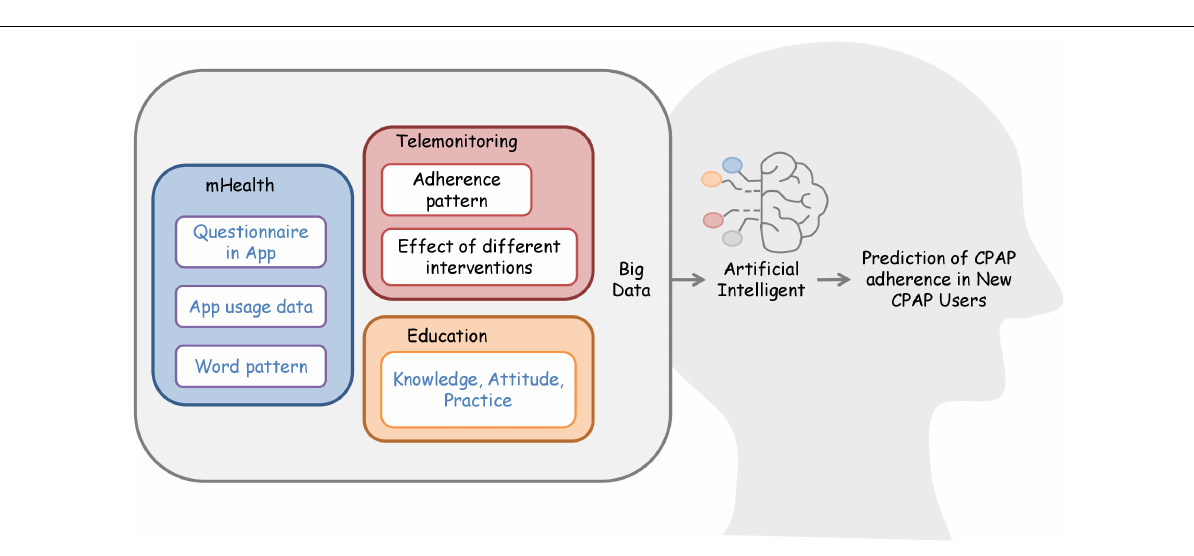
FIGURE 2 | Integration of big data and artificial intelligence for the development of the predictive model. Collection of adherence data from telemonitoring able to generate adherence patterns database. Future studies can use the database to continue work on the artificial intelligence model to predict CPAP adherence. Researchers can also consider building biopsychosocial databases by retrieving data such as psychological, social, and clinical questionnaires in-app. Developers can collect app usage data and word patterns used in telecommunication apps to train the artificial intelligence model to predict CPAP adherence. For